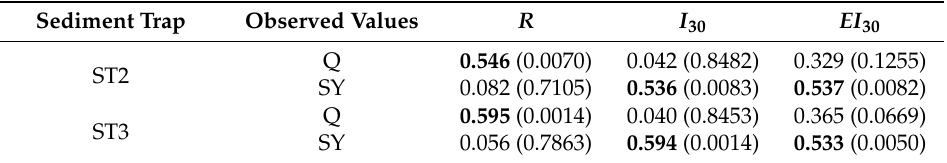
Table 6. Pearson’s correlation coefficients between observed runoff (Q) and sediment (SY) yields at each sediment trap (ST) during the 26 time-integrated surveys (TIS) and the corresponding values of rainfall depth ( R ), maximum intensity ( I 30 ) and erosivity ( EI 30 ) calculated from the synthetic weather station. Significant level between brackets: coefficients in bold are significant at the 0.01